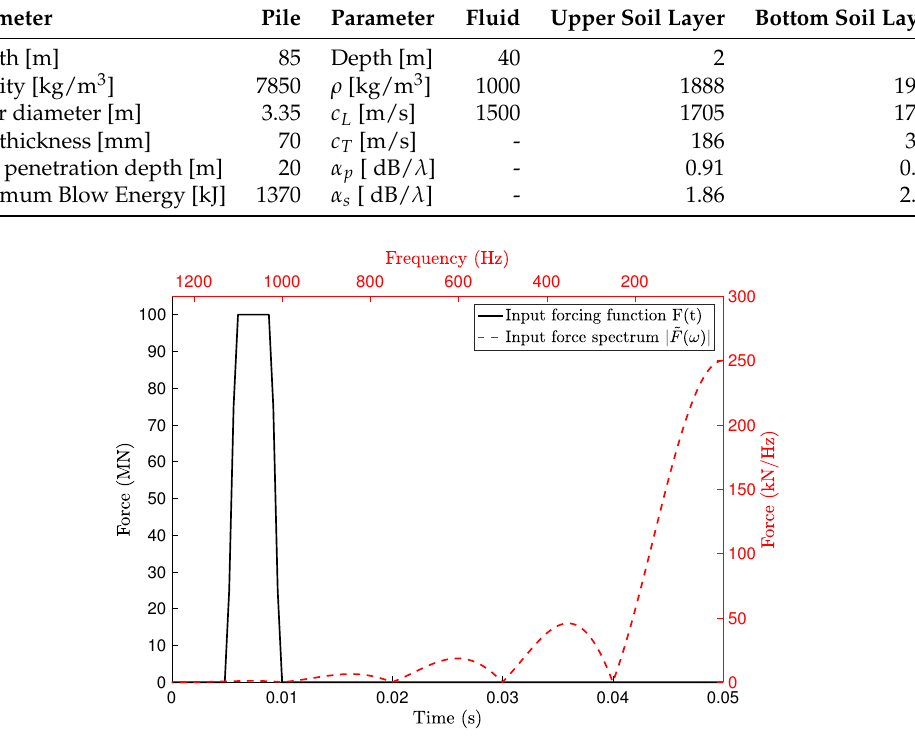
Figure 7. Impact force in the time domain and corresponding amplitude-frequency characteristic for the case study BARD Offshore I wind